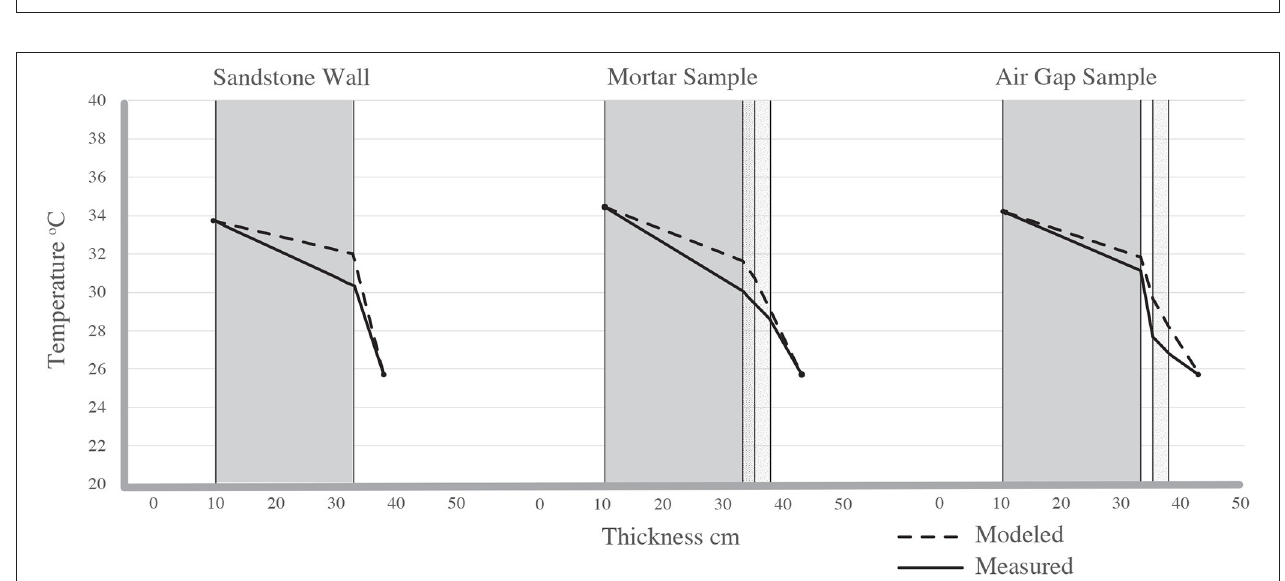
FIGURE 6 | Section of test walls at Bhuj showing heat flow through the